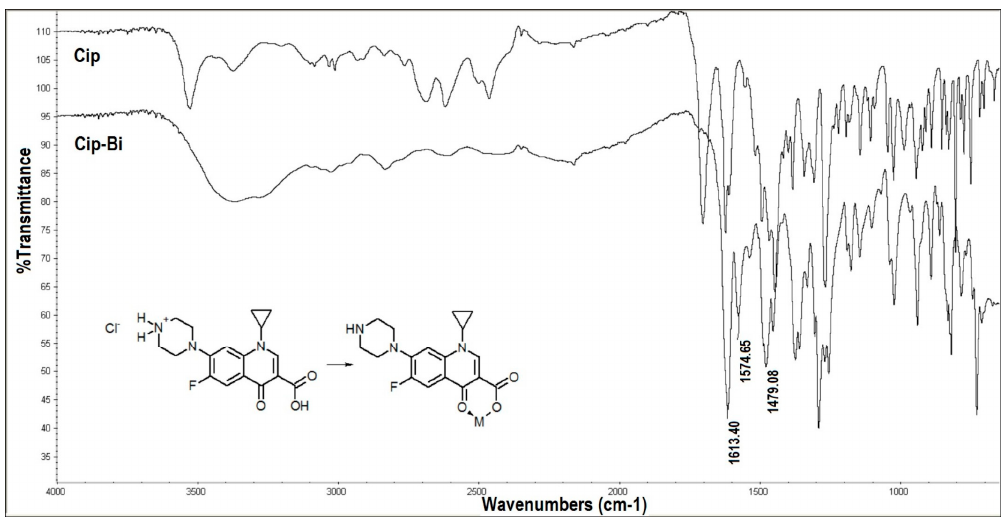
Figure 1. Fourier transform infrared (FTIR) spectra obtained for ciprofloxacin (Cip) as hydrochloride and ciprofloxacin-bismuth complex (Cip-Bi).